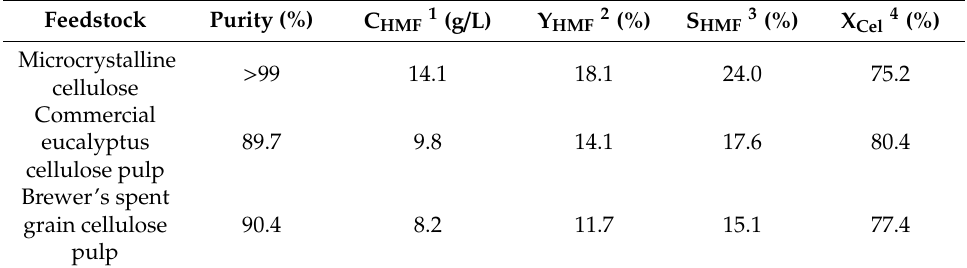
Table 7. Assays results carried out with feedstock from di ff erent sources of cellulose.